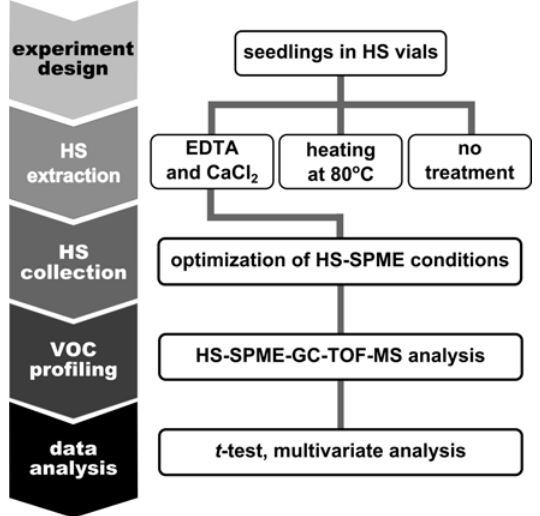
Figure 1. Volatile organic compound (VOC) profiling of Arabidopsis seedlings directly in headspace (HS) vials. Abbreviation: EDTA, ethylene-diamine-tetra-acetic